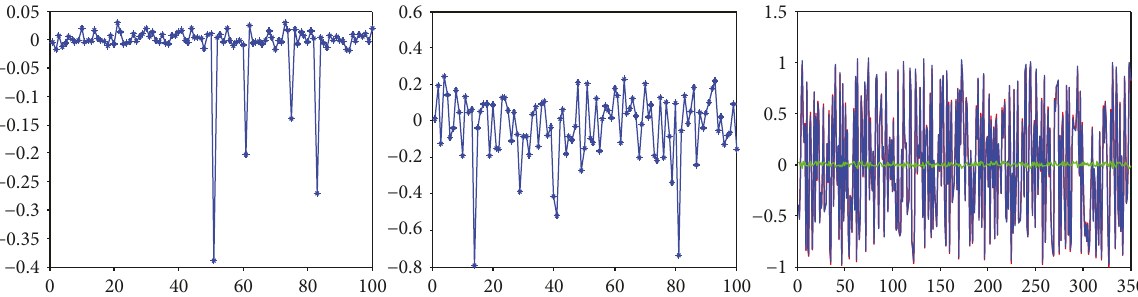
Figure 9: Evaluation index training data